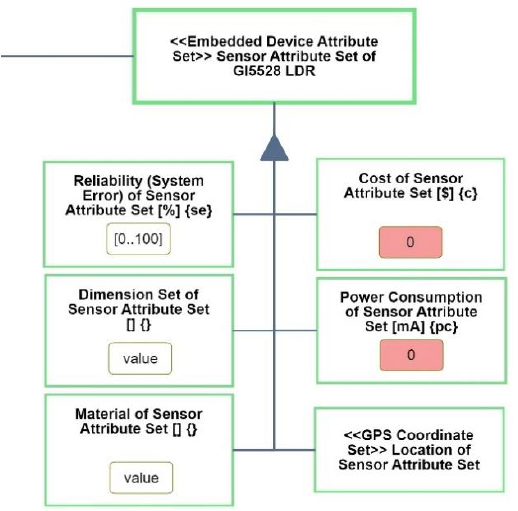
Figure 21. The sensor GI5528 LDR attribute set in soft validation marked red.